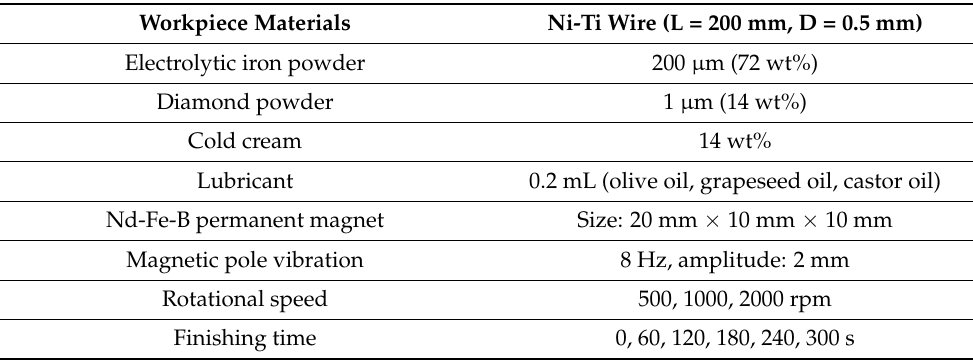
Table 2. Experimental